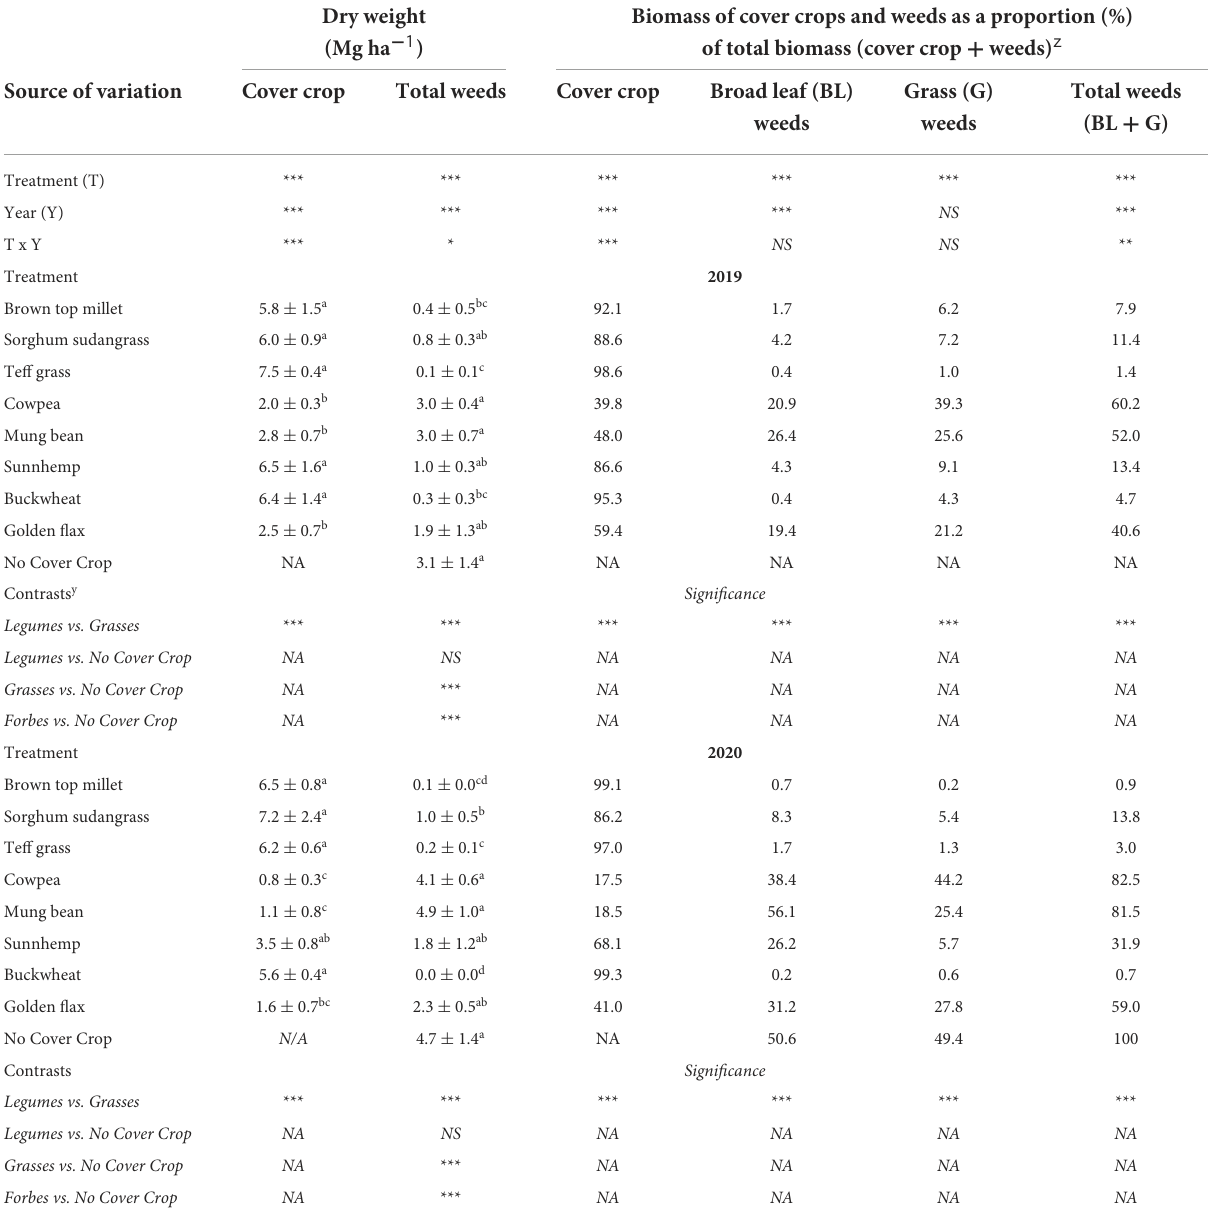
TABLE 4 Results of analysis of variance and treatment means for the effect of cover crop biomass, weed biomass, and the proportion of cover crops and weeds to total biomass and the associated single degree of